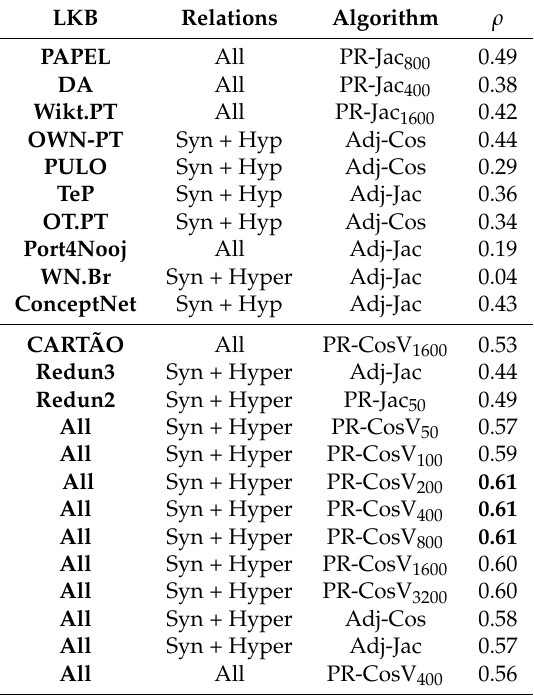
Table 13. Selection of results for the SimLex-999 test. LKB Relations